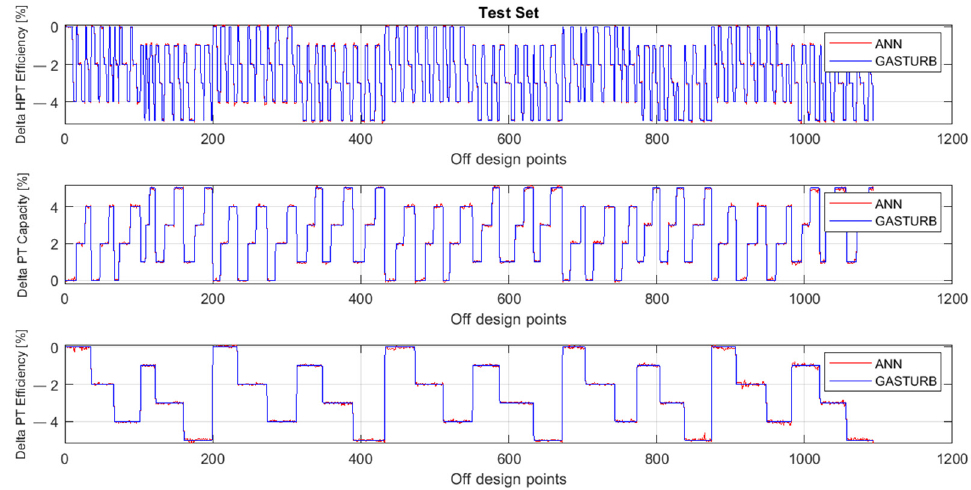
Figure 4. Fault parameters Δ HPTE, Δ PTC, and Δ PTE, true and simulated by MLP (Validation set).